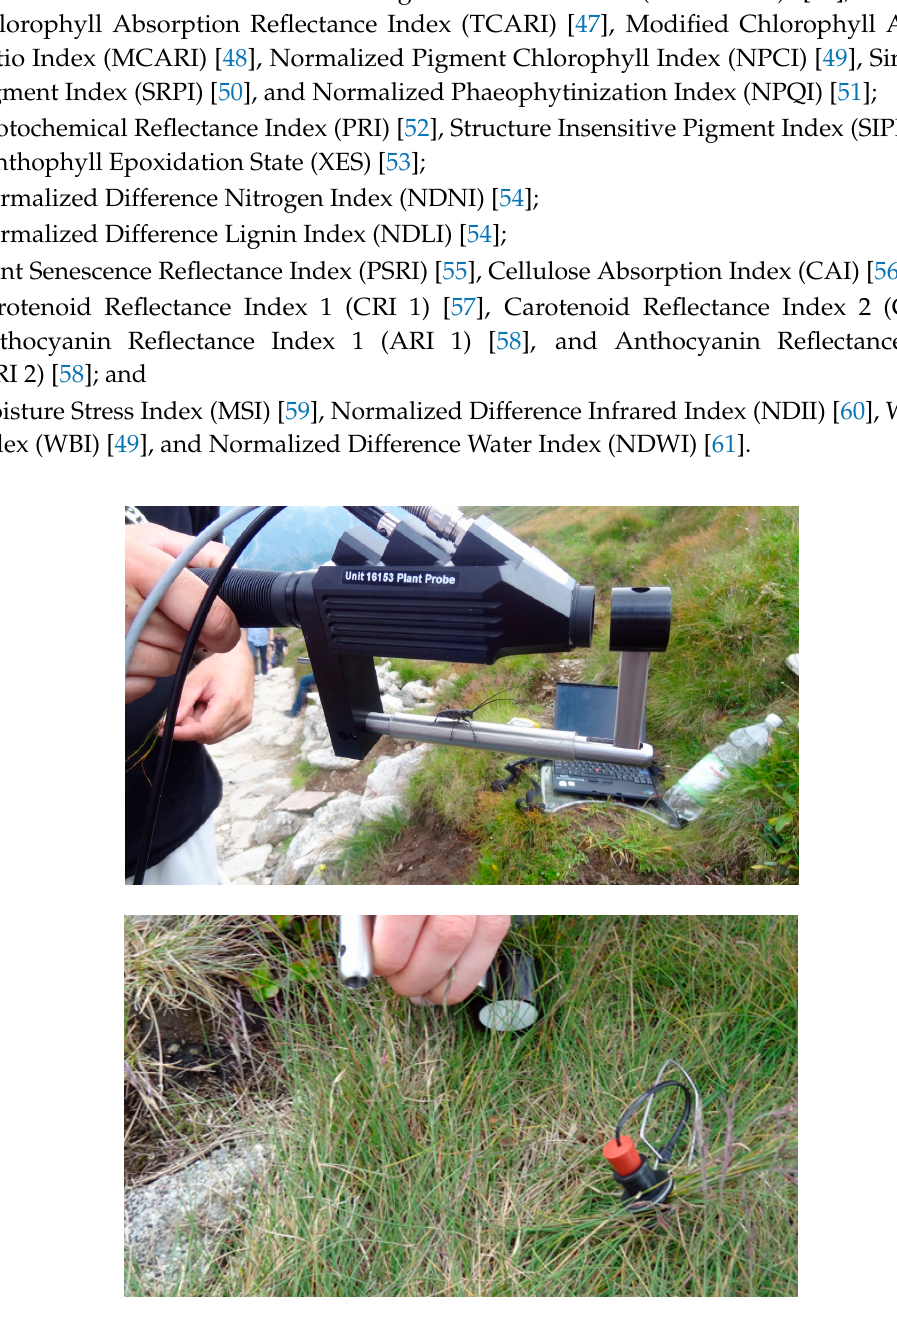
Figure 3. Hyperspectral measurements by ASD PlantProbe (upper picture), which is connected to the ASD FieldSpec by an optical fiber cable (black one on the upper picture). A closed leaf clip (picture lower part) is used for adapting leaves to the darkness before measurements of chlorophyll fluorescence.